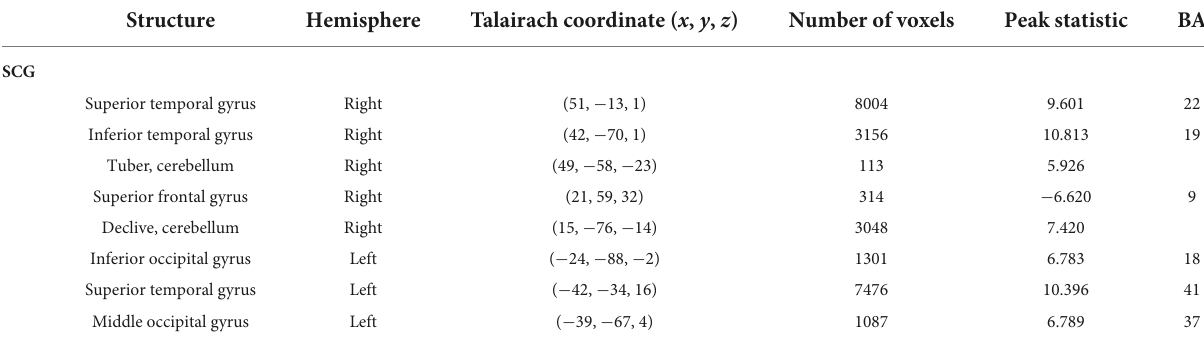
TABLE 2 Results of the auditory feature analysis for the median values of